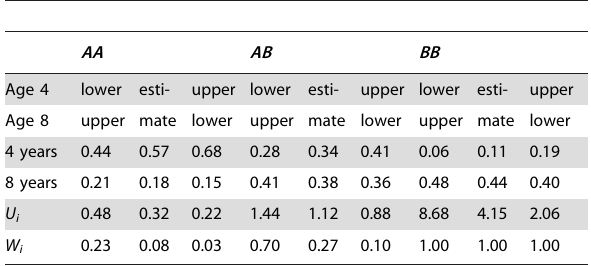
Table 6. Predicted genotypic frequencies, weights and